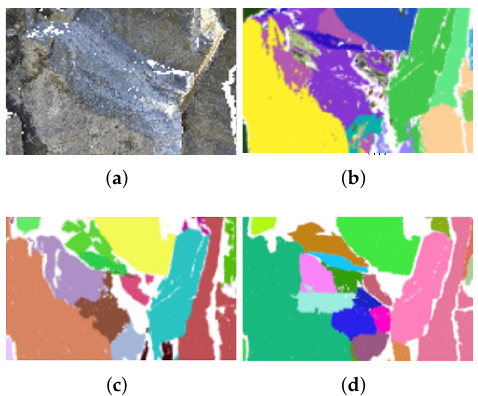
Figure 3. Segmentation results under different structural degrees. ( a ) A surface area without clear boundaries. ( b ) Unstructured. ( c ) Semi-structured. ( d ) Completely